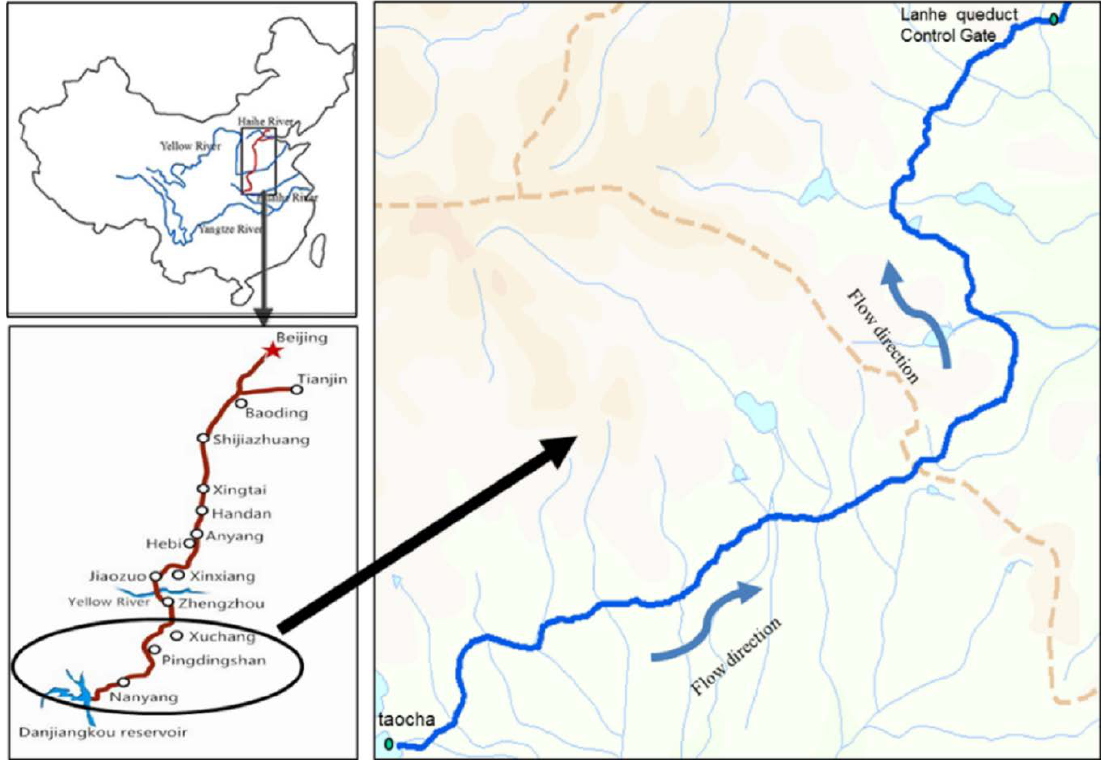
Figure 3. Field investigation area.